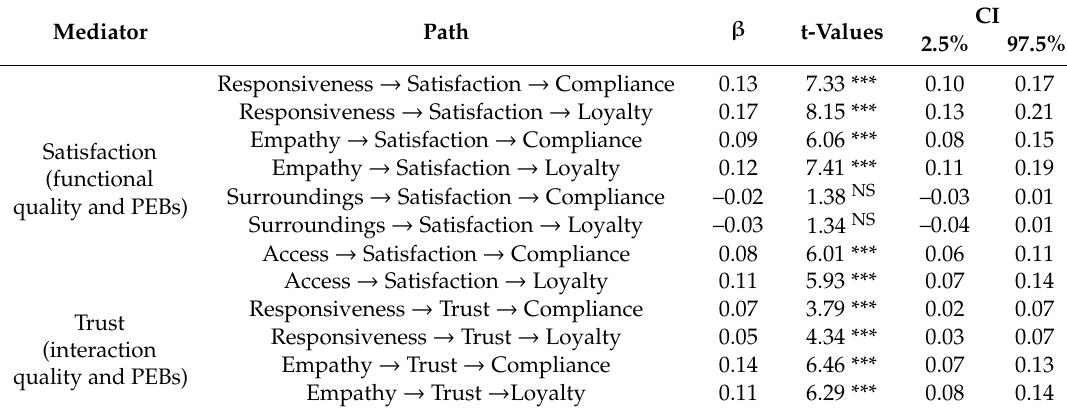
Table 7. Results regarding indirect e ff